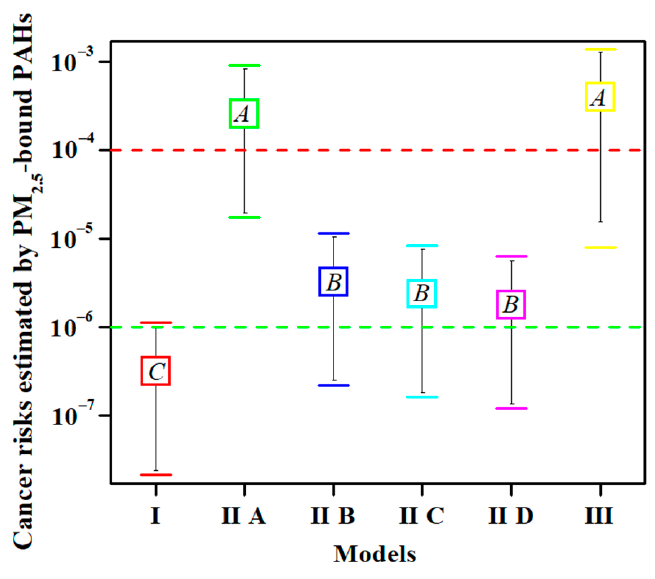
Figure 1. The analysis of variance and multiple comparisons among the total cancer risks calculated using the different models ( n = 39, p < 0.01). Note: The upper and lower horizontal lines in each group represent upper and lower limits, respectively. The box represents the average value. The same letter in the box indicates that the difference is not significant. One-way analysis of variance was used to determine the significance of differences, and Tukey’s test was used for multiple comparisons. The green dotted line represents an acceptable level of cancer risk. The red dotted line represents moderate risk.